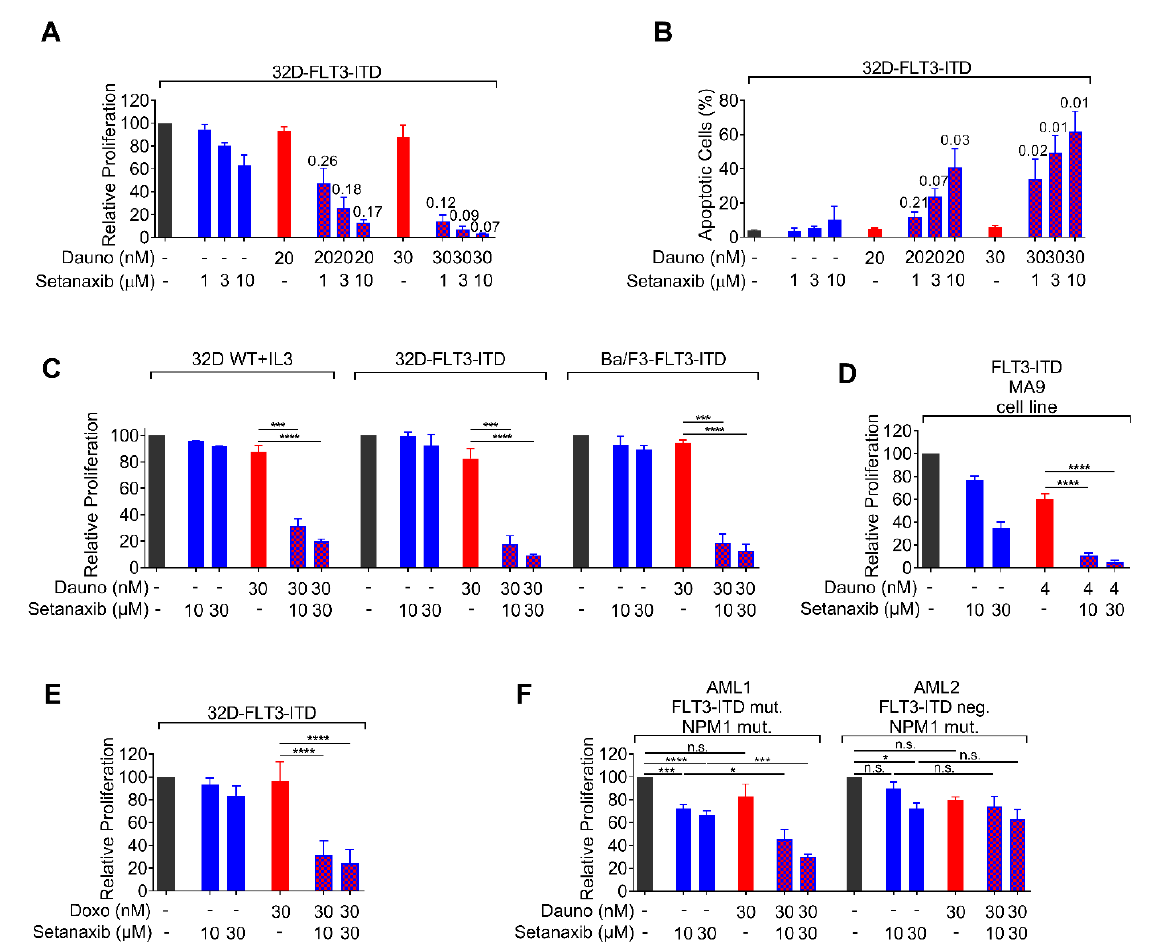
Figure 2. Effect of the single and combined drug treatments on proliferation/viability and induction of apoptosis in AML cells. ( A ) 32D-FLT3-ITD cells were seeded in 96-well plates, single compounds or combinations of compounds (daunorubicin, Setanaxib, or combinations) were added, and the proliferation/viability was assessed by Cell Titer Blue assay after 72 h. The fluorescent signal, which was directly proportional to the number of viable cells, was measured in a plate reader at 540/610 nm (excitation/emission, respectively, RFU-relative fluorescence units). ( B ) Apoptosis rate was measured by FACS analysis using Annexin V/7-AAD staining after 48 h of single or combined treatments with daunorubicin and Setanaxib. The combination index was determined using the software Calcusyn. The obtained ‘combination index (CI)’ numbers are shown above the bars. Three independent experiments were conducted; error bars represent mean ± SD. ( C ) Comparison of synergistic effects in wildtype (WT) FLT3-expressing 32D-cells, FLT3-ITD-expressing 32D- cells, and Ba/F3-FLT3-ITD cells. Note that the cultivation of WT-FLT3 32D cells requires addition of IL-3 to the medium. ( D ) Synergy of Setanaxib and daunorubicin in a murine leukemic cell line transformed with FLT3-ITD and MLL-AF9 obtained as indicated in the legend to Figure 1. ( E ) Synergy of Setaxanib with doxorubicin in 32D-FLT3-ITD cells. The individual experiments were normalized to DMSO controls. Three independent experiments (with technical triplicates) were conducted; error bars represent mean ± SD. (**** p < 0.0001 by two-tailed t -test). Note that for clarity in ( C – E ) only selected statistical comparisons are shown to emphasize the synergistic effects of Setanaxib addition to a dose of anthracycline, which has limited effect alone. ( F ) Synergy of Setanaxib with daunorubicin in primary human AML cells. Primary patient PBMCs were isolated by Ficoll density gradient separation. Cells (100,000 cells/well) were treated with drugs or their combinations as indicated. Proliferation was assessed as in ( A ). The individual experiments were normalized to DMSO controls. Error bars represent mean ± SD. Statistical analyses were carried out using one-way ANOVA with Tukey’s post-test. (n.s.—not significant, * p < 0.05 and *** p <